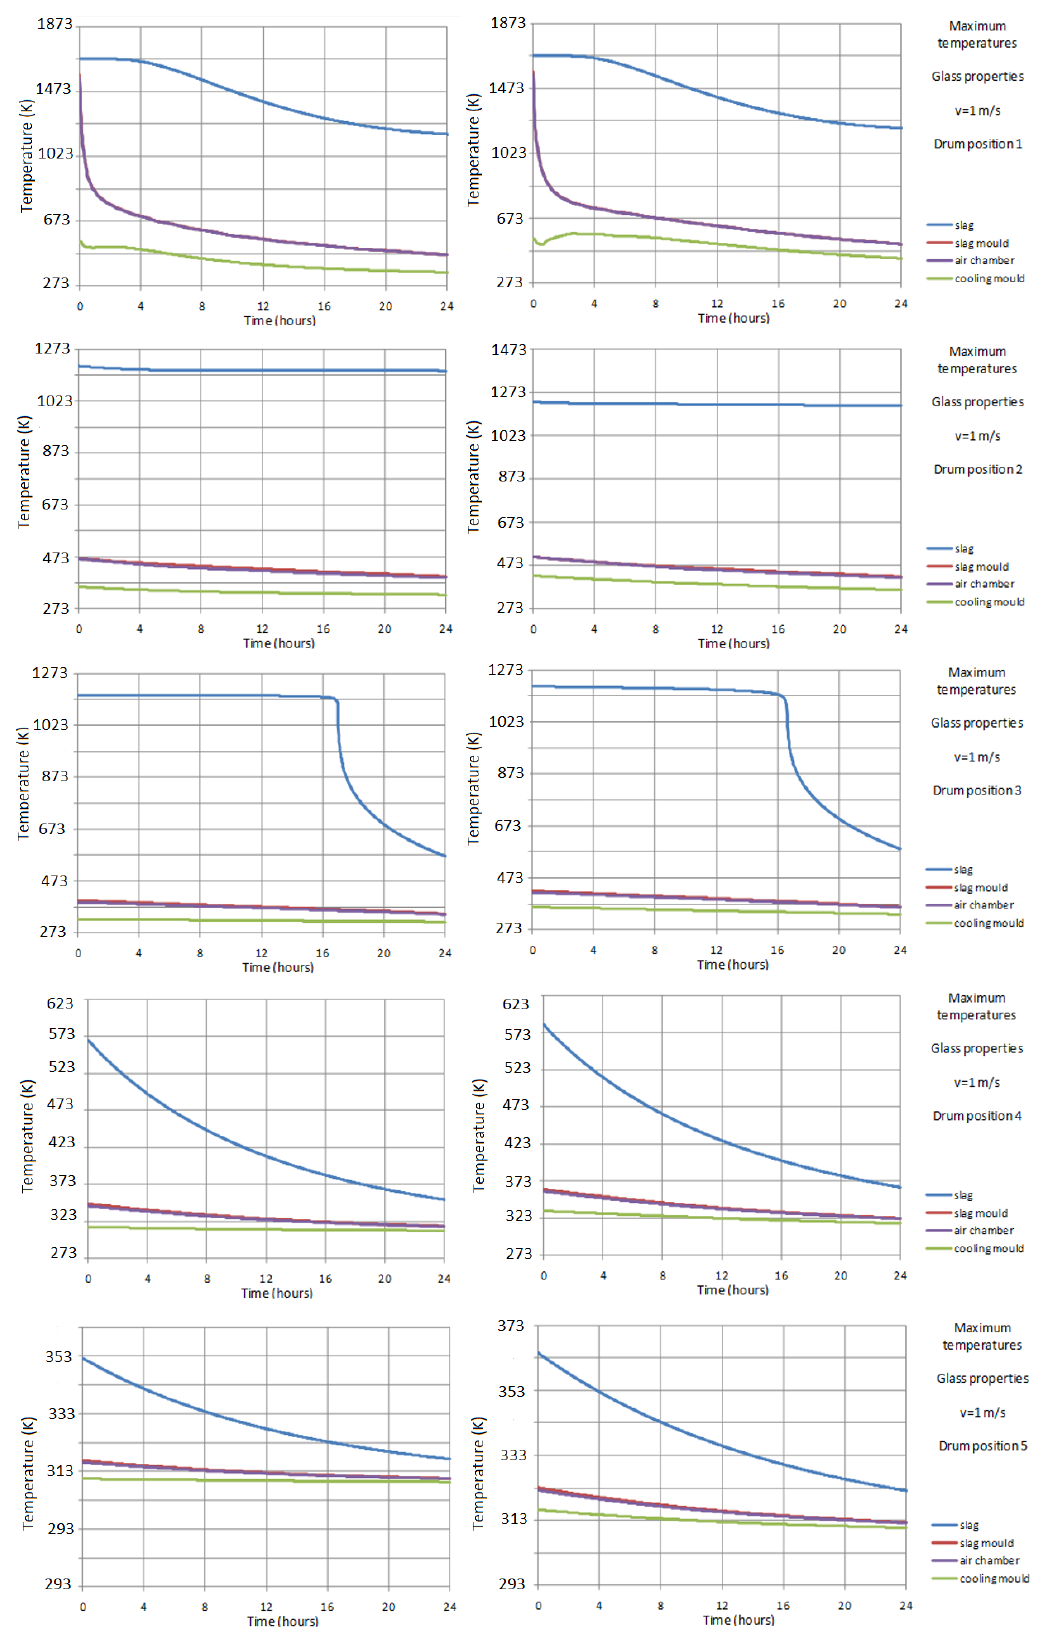
Figure 7. Maximum temperatures during the cooling process (glass properties) for drum 1 ( top ), to drum 5 ( bottom ). Left : v = 3 m/s. Right : v = 1 m/s.